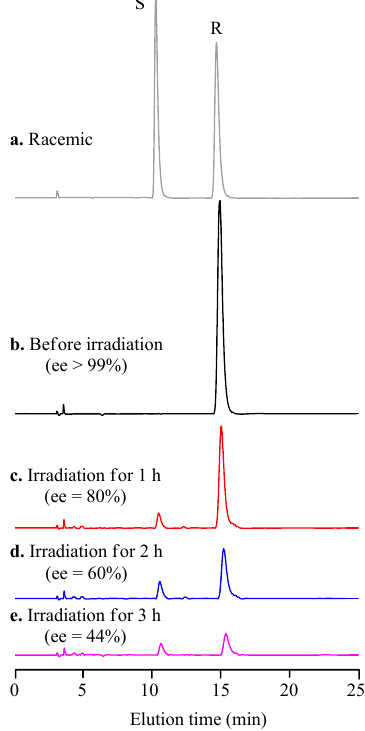
Figure 2. HPLC chromatograms of samples obtained from ( R )-BINOL in a CH 3 CN solution upon irradiation ([( R )-BINOL] o = 1.0 × 10 − 3 M, cell path = 5 mm, solution volume = ca. 1.75 mL) and standard samples: ( a ) standard racemic BINOL; ( b ) standard ( R )-BINOL; ( c – e ) samples after irradiation for 1 h, 2 h, and 3 h, respectively.